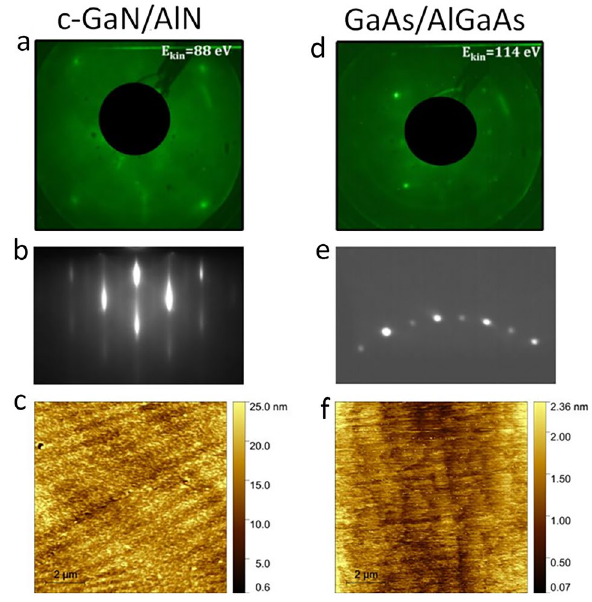
Figure 2. Characterization of the surface properties of the c-GaN/AlN and GaAs/AlGaAs samples. LEED pattern are shown in ( a ) and ( d ); RHEED in ( b ) and ( e ), and AFM in ( c ) and ( f